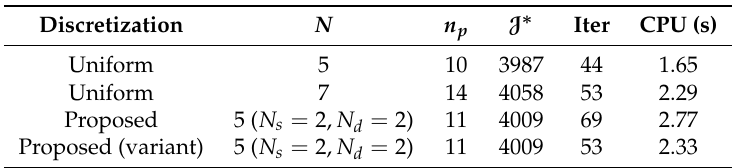
Figure 10. Optimal trajectories for Problem (40) with a short time horizon solved using the proposed approach and N = 5 epochs. Table 4. Optimal objective values, number of iterations, and CPU times for different discretization strategies in Problem (40) for the case of a short time